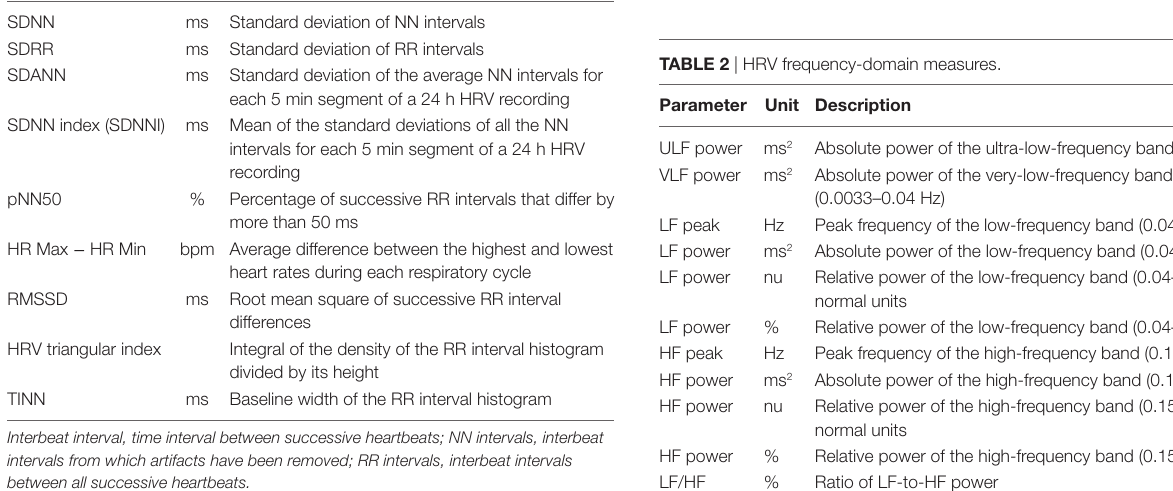
TABLe 1 | HRV time-domain measures. Parameter